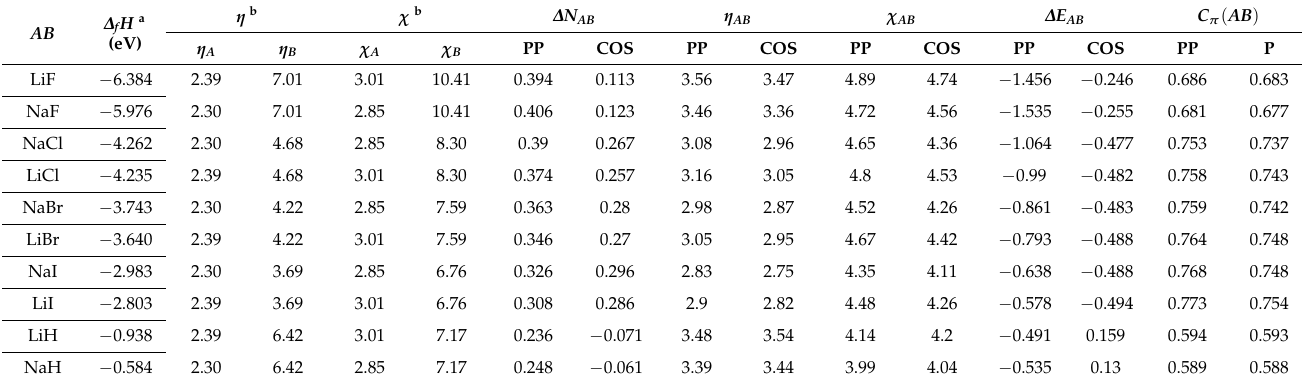
Figure 6. Estimated energies within Parr–Pearson (PP) and chemical orthogonal space (COS) vs. standard enthalpy of formation ( ∆ f H ) at 298.15 K for the halogen acids of Table 2, manifesting better molecular ground-to-valence states’ sub-classification for the later, respectively. Table 3. The same type of data as in Table 2, but for alkaline hydrides and salts as polar molecules in a crystal state.